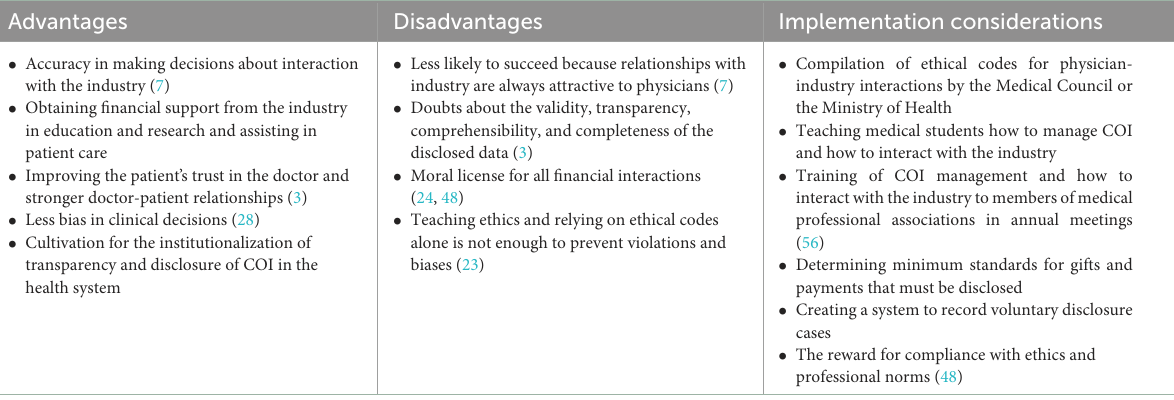
TABLE 5 Advantages, disadvantages, and implementation considerations of policy options: 3. Physician self-regulation.